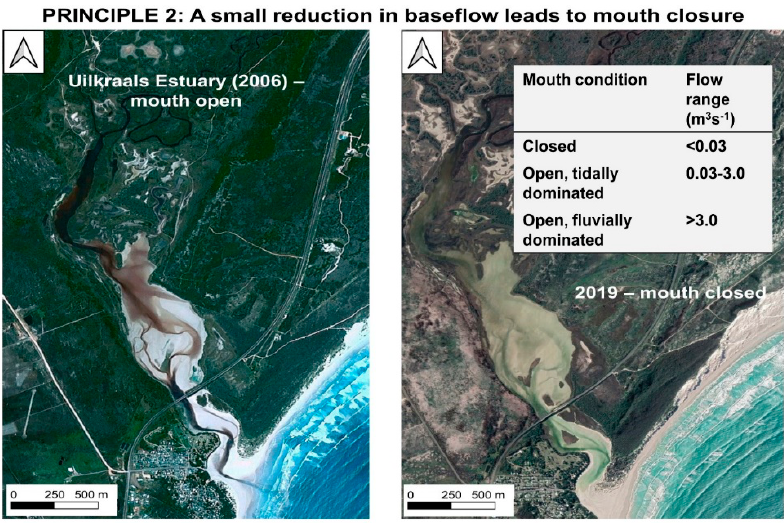
Figure 5. The Uilkraals Estuary open in 2006 ( left ) and closed in 2019 ( right ).